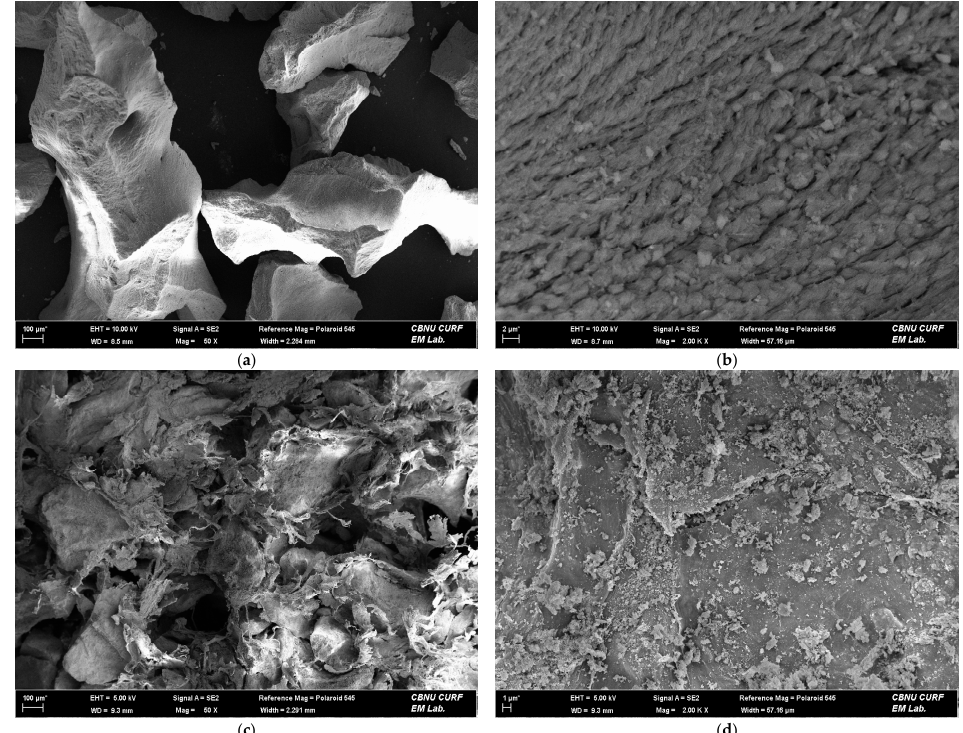
Figure 1. Field emission scanning electron microscope images of each bovine bone scaffold: Particle bovine bone scaffold (( a , b ); original magnification 50 × , 2000 × , respectively), Block bovine bone scaffold (( c , d ); original magnification 50 × , 2000 × , respectively).